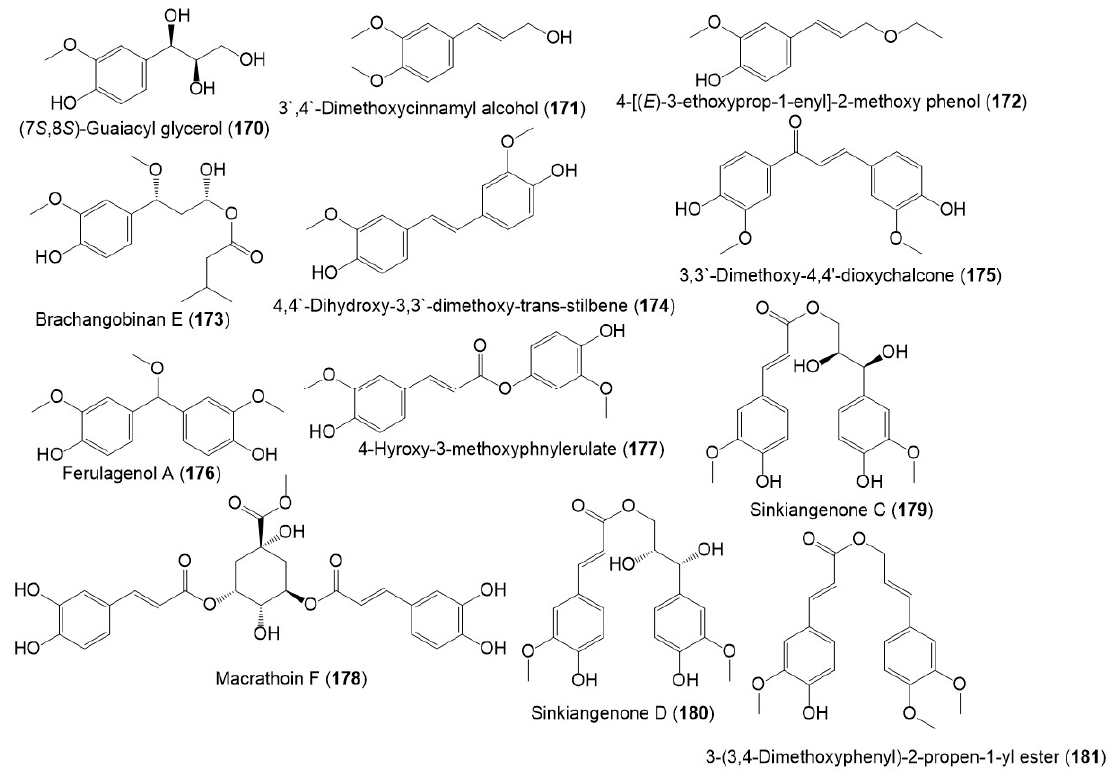
Figure 19. Structures of phenolic compounds ( 170 – 181 ) reported from F. sinkiangensis .